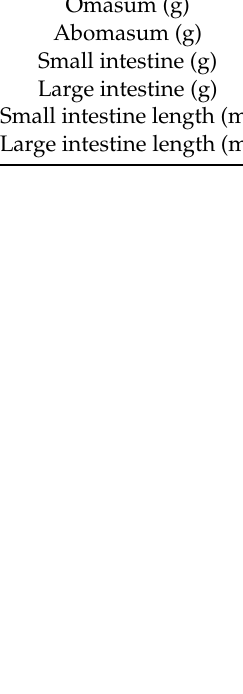
Table 2. Morphological characteristics of the small intestine of lambs following different grazing